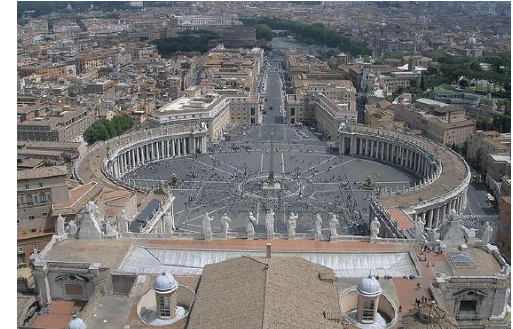
Figure 12. Centrality representing spatial quality. Example St Peter’s, Rome.